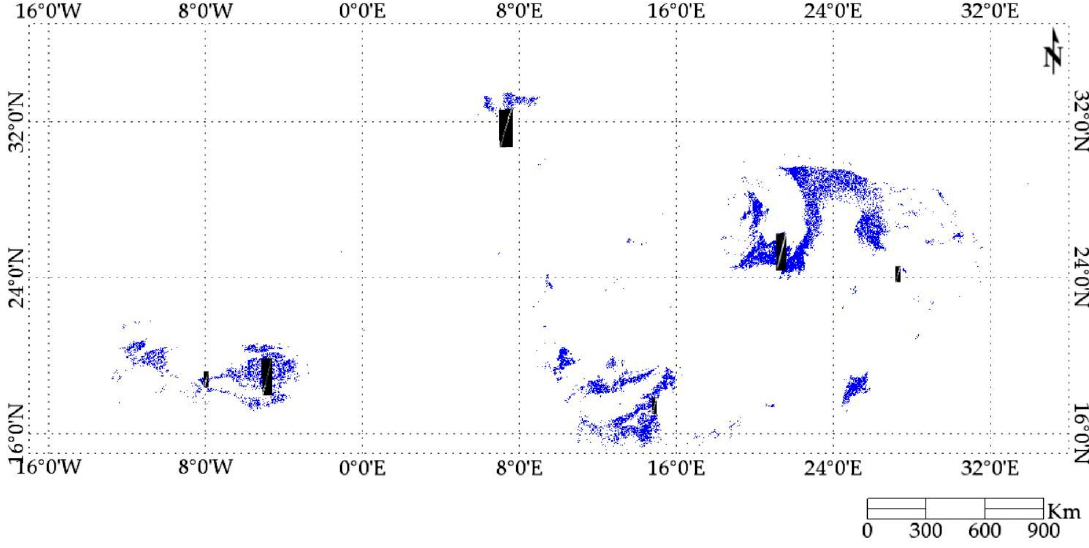
Figure 4. Extent of cluster 13 over North Africa. Blue color represents cluster 13 pixels. Black rectangle boxed represent the regions used for validation.